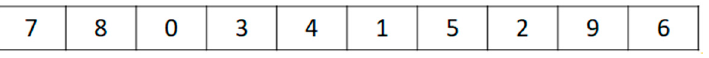
Figure 11. Graphical representation of a chromosome.